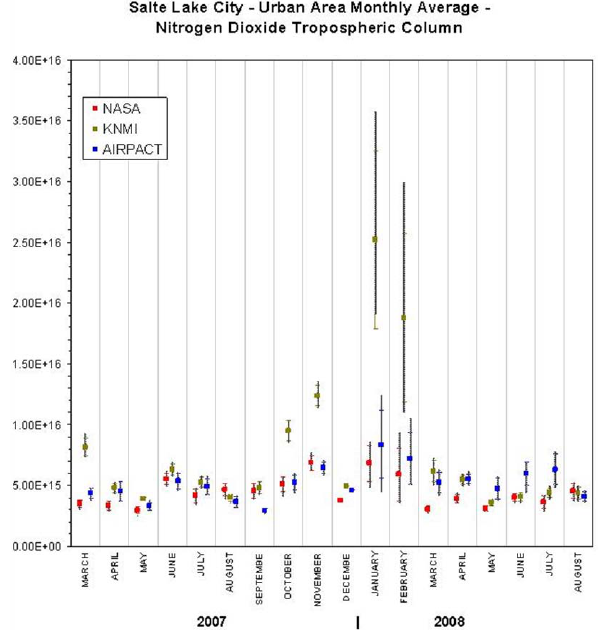
Fig. 9. Monthly Average NO 2 for Salt Lake City, Utah over 18 months. The bars show standard deviation of spatial variation over a 720km 2 area (5 AIRPACT pixels) while the whiskers show the extent of the maximum and minimum. Values are in molecules per square